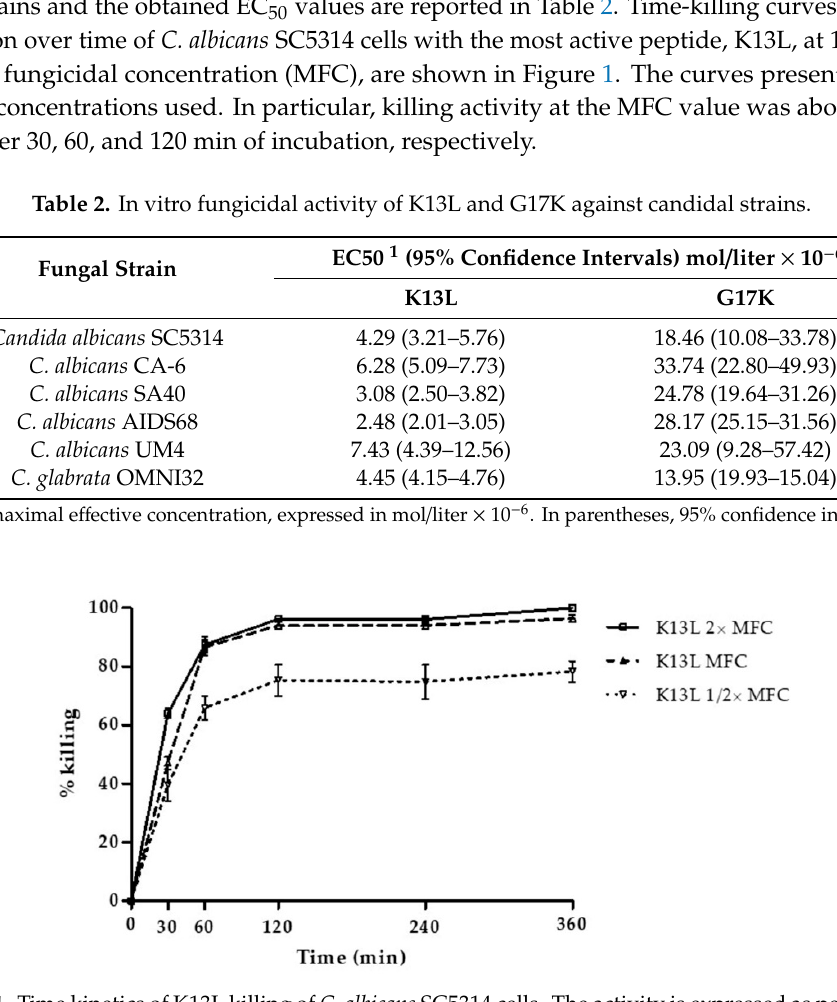
Figure 1. Time kinetics of K13L killing of C. albicans SC5314 cells. The activity is expressed as percentage killing, calculated as: 100-(average number of colony forming units (CFUs) in the peptide-treated group/average number of CFUs in the control group) × 100. Each experiment was performed in triplicate.